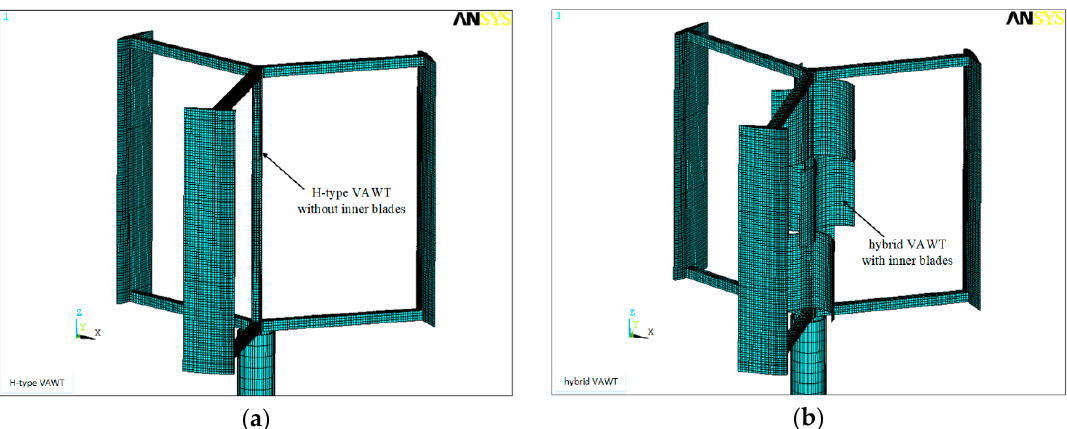
Figure 1. Shapes of the ( a ) H-type and ( b ) hybrid VAWTs, where the hybrid VAWT has inner blades and the H-type VAWT does not have them.